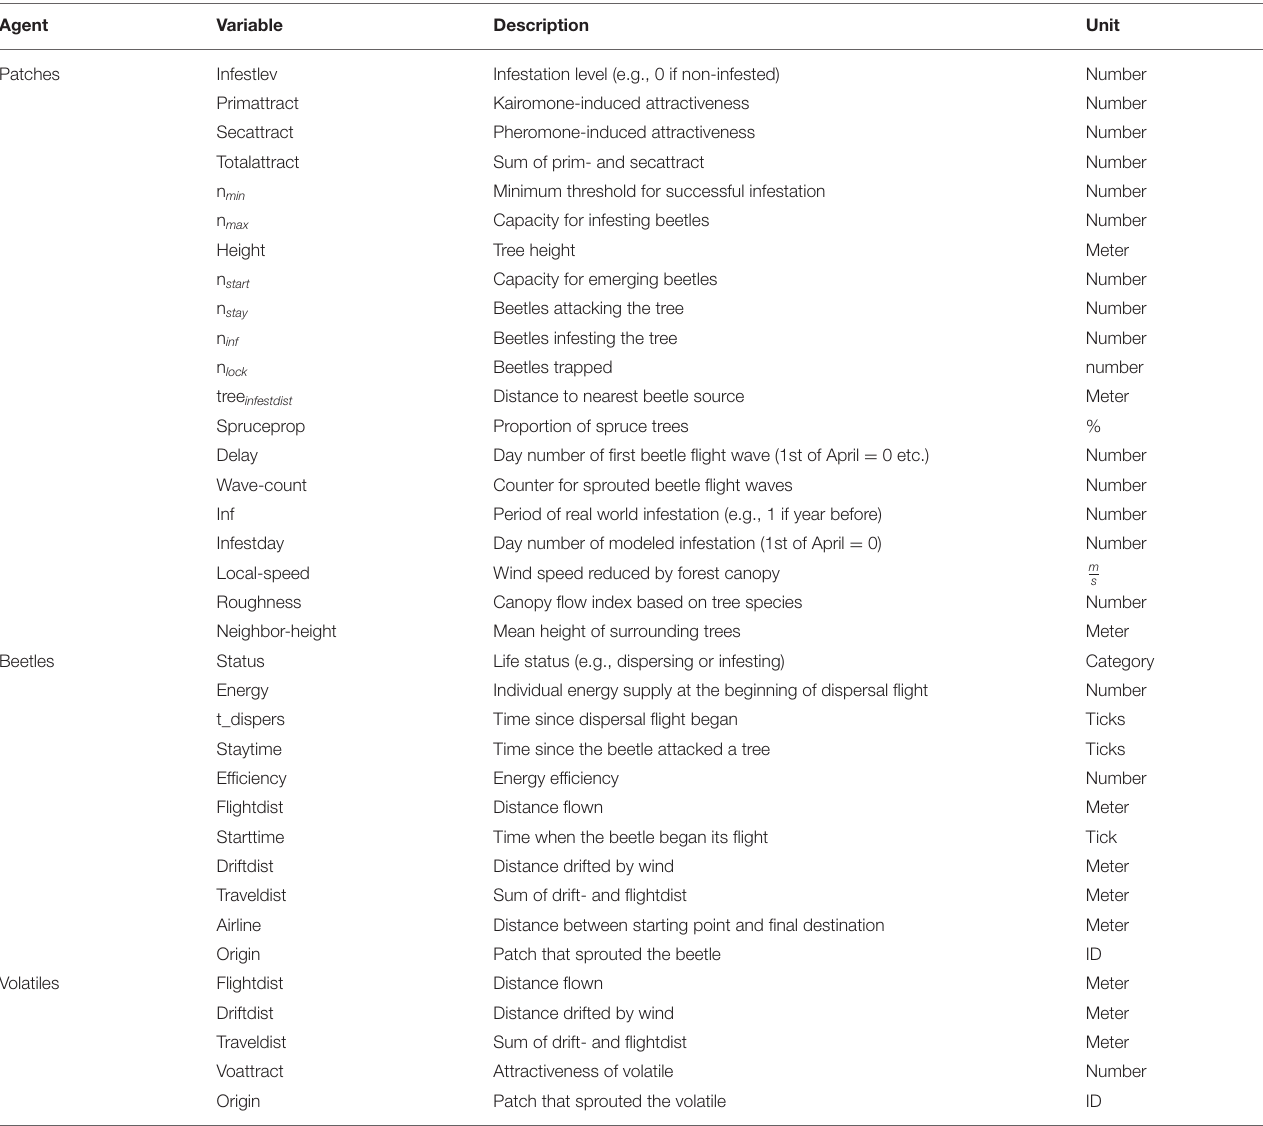
TABLE 1 | Entities and state variables of the IPS-SPREADS model.